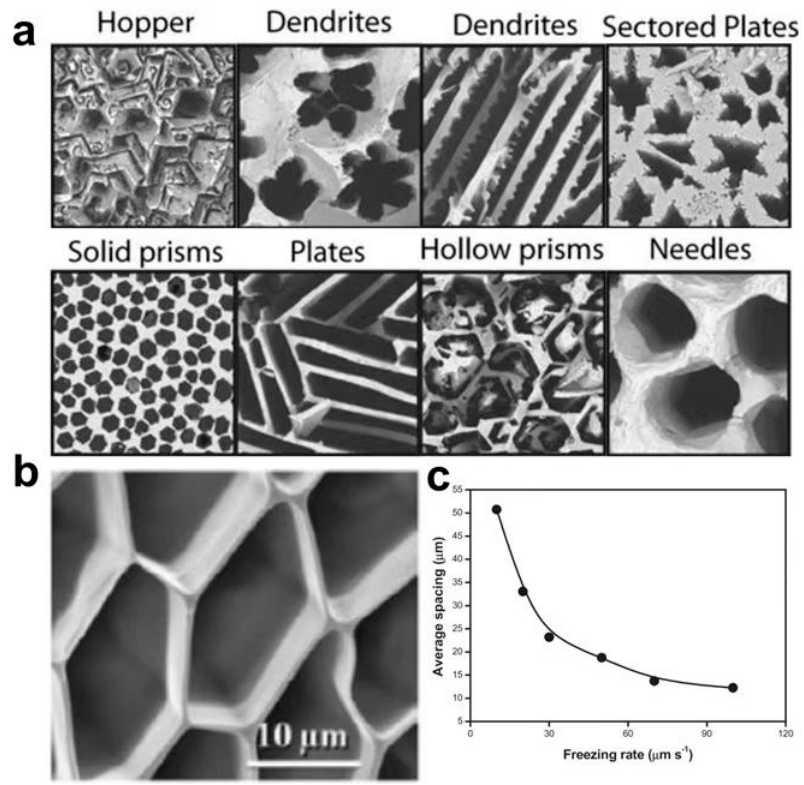
Figure 3 . ( a ) Typical hydrogel pore morphology obtained by controlling ice crystal growth. Reprinted with permission from Reference [63]. ( b ) SEM cross-section of regular PVA hydrogels obtained by directional freezing technique. ( c ) Relationship between freezing rate and pore size. Reprinted with permission from Reference [64].